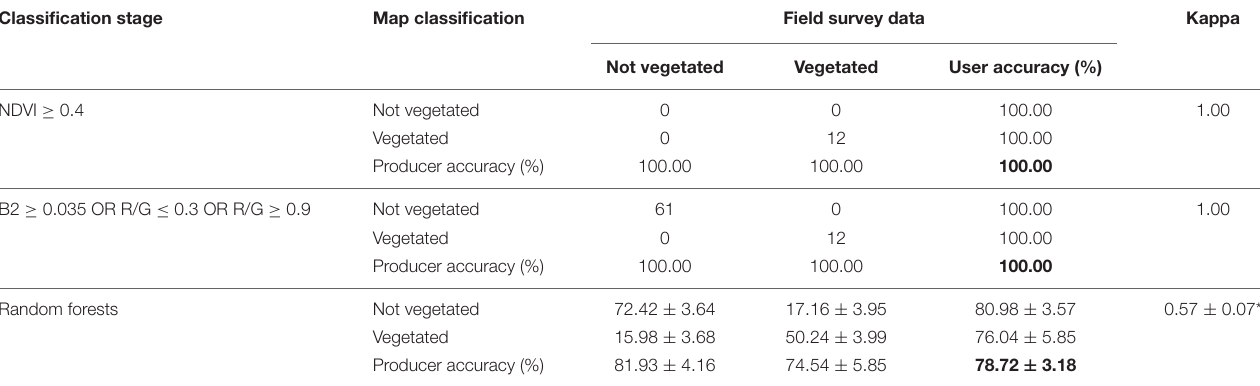
TABLE 2 | Confusion matrix after each classification step has been added in. Overall map accuracy is bolded. Kappa significance indicated by asterisk ( *